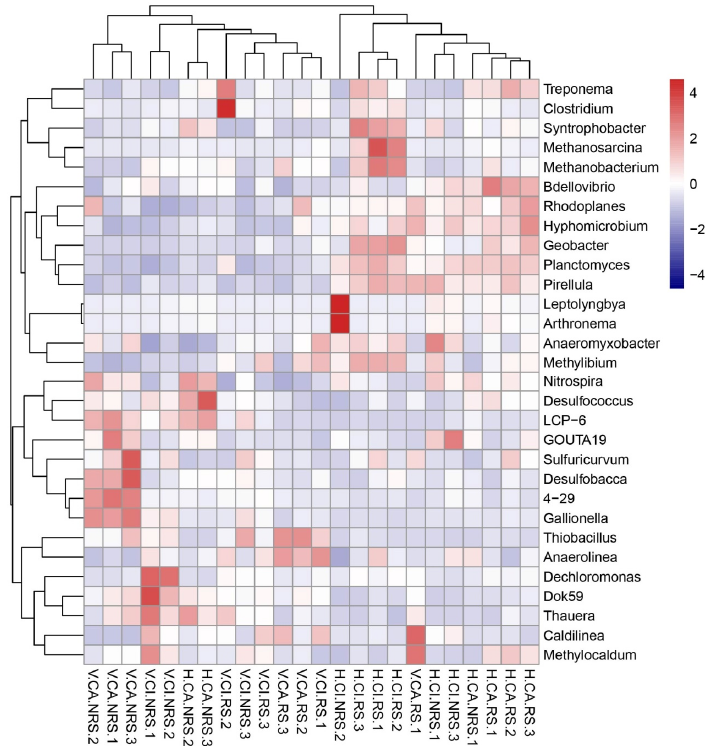
Figure 3. Relative abundance (%) of top 30 microbial genera across the two wetlands revealed by 16S rRNA MiSeq sequencing. The samples numbers were shown in Figure 2. The richness and diversity indexes No. of OTUs, Faith’s PD and chao 1 ranged from 4109 to 5145, from 269 to 351 and from 11,533 to 16,279, respectively (Table S2 in Supplementary Information). For CI in the HSFCW and CA in VSFCW, the microbial diversity was significantly higher in the RS than that in the NRS ( p < 0.005), for CA in the HSFCW and CI in VSFCW, the microbial diversity showed no significant difference in the RS and NRS (Table S2 in Supplementary Information). Results of the Unifrac-based PcoA showed that the samples distributed in different parts of the data space (Figure S2 in Supplementary Information), indicating significant differences in sediment community compositions among the sampling sites. For VSFCW, the bacterial communities in the CI.NRS and the CA.NRS shared 1154 OTUs (20.2%) and 1402 OTUs (24.8%) were shared by two communities in the CI.RS and the CA.RS, respectively (Figure 4). For HSFCW, the bacterial communities in the CI.NRS and CA.NRS shared 1162 OTUs (18.8%) and 1457 OTUs (23.9%) were shared by two communities in the CI.RS and CA.RS, respectively. For two CWs, the OTUs was significantly higher in CA group than that in CI group. The results showed that the microbial diversity of CA group was higher than that of CI group.